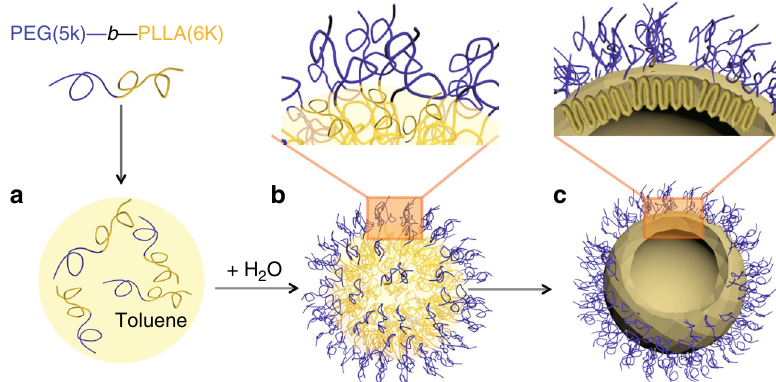
Fig. 1 Fabrication of PLLA- b -PEG block copolymer crystalsomes. a Dissolution of the BCP in toluene; b emulsi fi cation at 95 °C; c quenching to 25 °C for crystallization. The driving force of this assembly process is con fi ned PLLA crystallization at the toluene/water interface, leading to a ninefold PLLA chain conformation as shown in c . This con fi ned crystallization process also leads to a 2.5 nm thick PLLA crystal layer, covered with a precisely controlled, uniform PEG brush layer (grafting density of 0.3 chain nm − 2